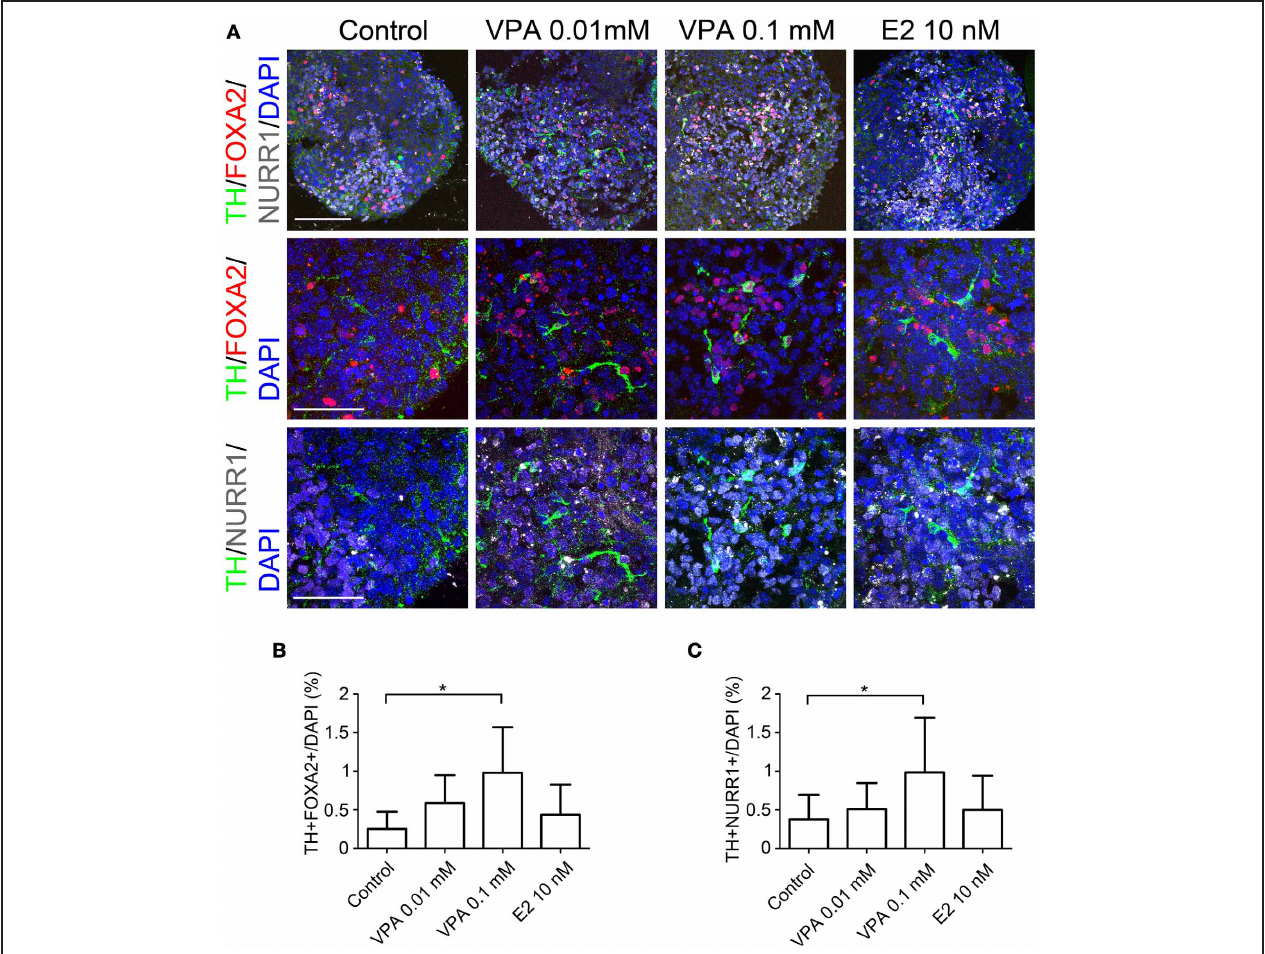
cultures. The scale bar applies to all pictures and represents 100 μ m (top) and 50 μ m (lower). (B,C) A comparison of the number of cells labeled for both TH and FOXA2 (B) or TH and NURR1 (C) per the total number of cells. The data are presented as the mean ± SD. ( ∗ P < 0 . 05; n =